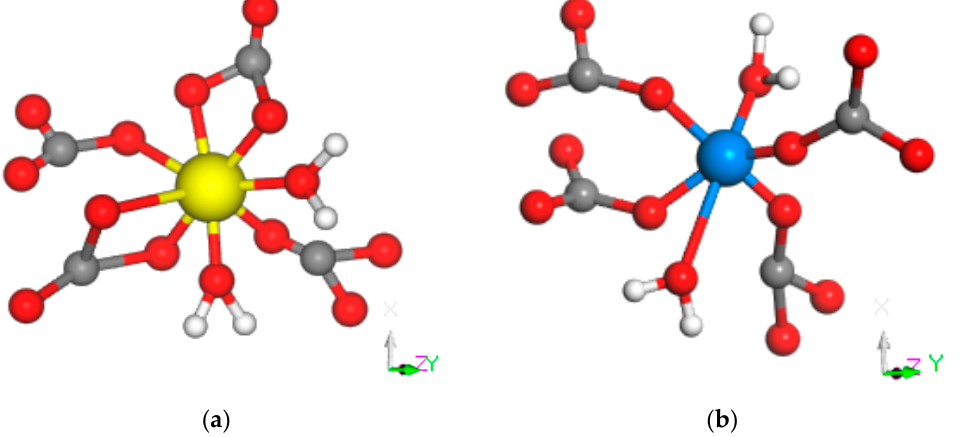
Figure 11. Local arrangements of monohydrocalcite provided by Fukushi et al. (2017). ( a ) The standard crystal structure of monohydrocalcite, CaO 8 polyhedron; ( b ) the changed crystal structure after replacement by a Mg atom, a MgO 6 polyhedron. The red spheres represent O, gray spheres denote C, white denotes H from H 2 O, yellow denotes Ca, and blue denotes